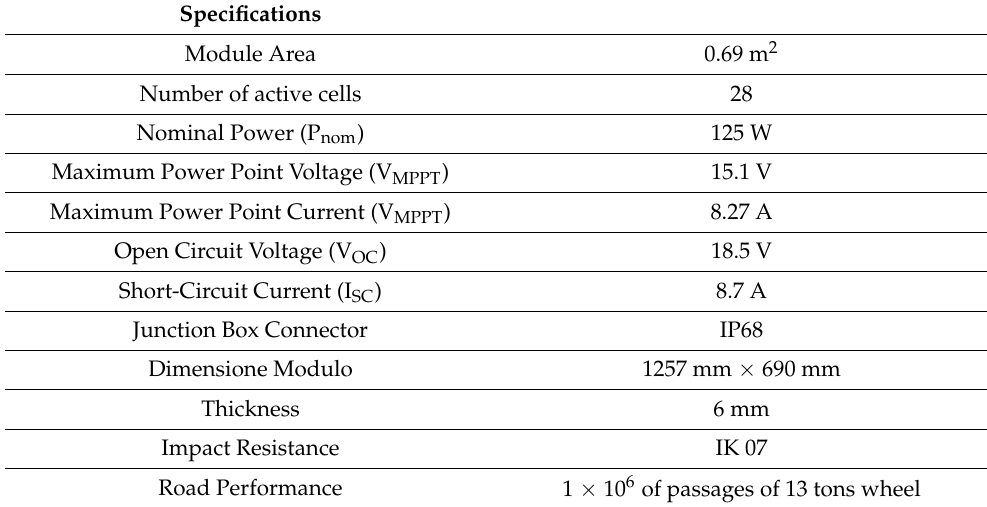
Table 4. Wattway module’s specifications